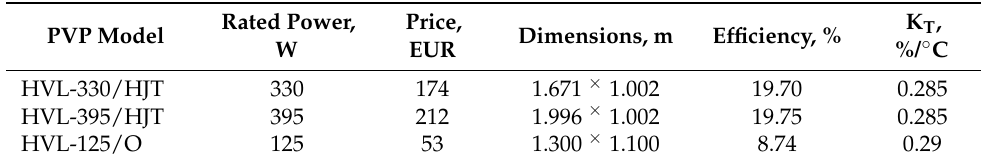
Table 1. Main characteristics of PVPs.